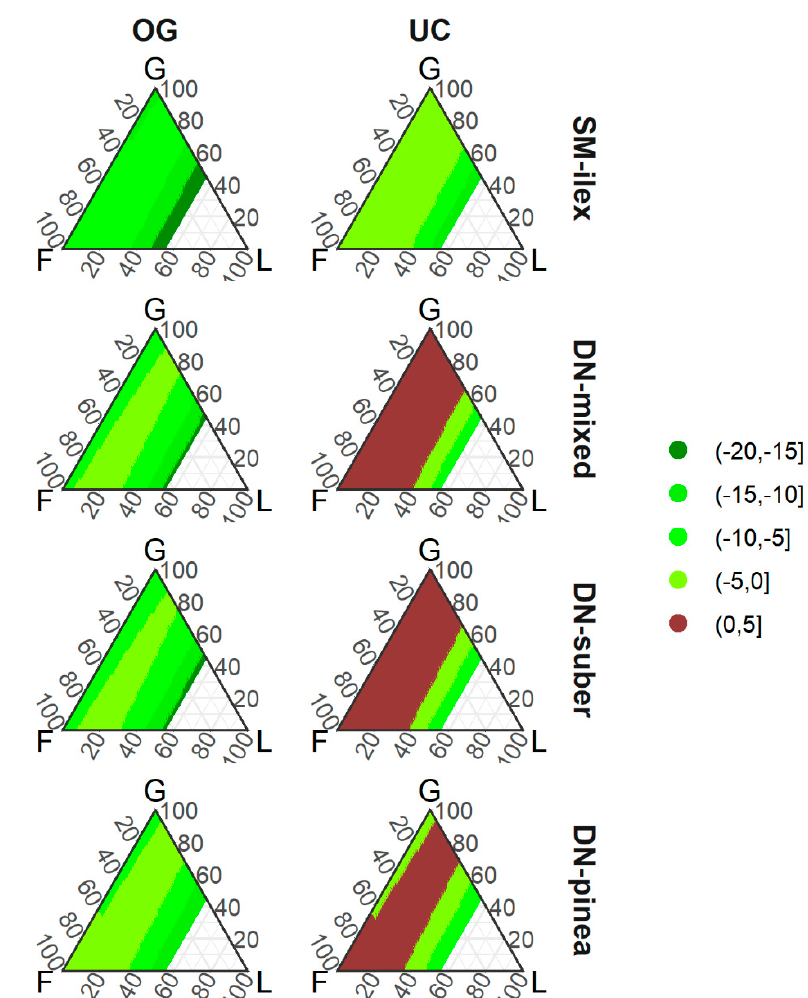
Figure 2. Predicted net ecosystem exchange (NEE, µ mol CO 2 m − 2 s − 1 ) according to the specific interaction model (Table 2). F indicates forbs, G grasses, and L legumes. Predicted NEE modeled with a maximum proportion of legumes of 50%, according to the legumes proportion observed in the field (Figure S3). Negative NEE values indicate net CO 2 uptake, and positive values indicate CO 2 emissions. Environmental conditions set as the mean of the given treatment level.